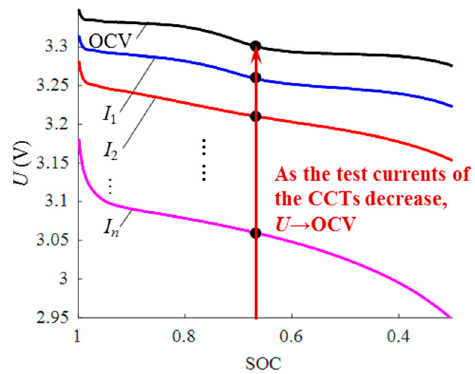
Figure 3. U approaches open circuit voltage (OCV) under the same T amb , as test currents of the constant current tests (CCTs) decrease.